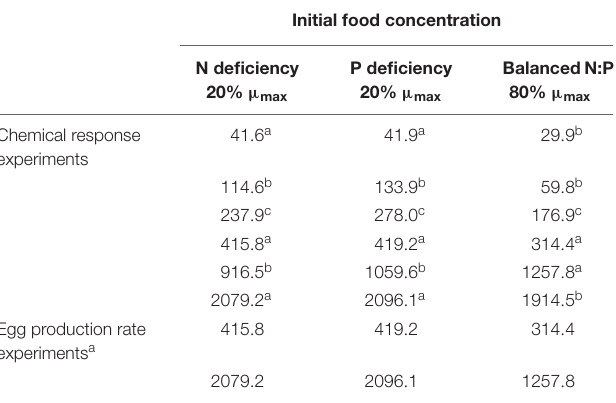
TABLE 1 | Initial food concentrations (calculated from the corresponding nominal initial food concentrations and algal carbon contents; µ g C L − 1 ) under different food quantity and quality treatments [the balanced and fast growth diet (80% of µ max ), and N- and P-deficient and slow growth diet (20% of µ max )] in copepod chemical response experiments and egg production rate